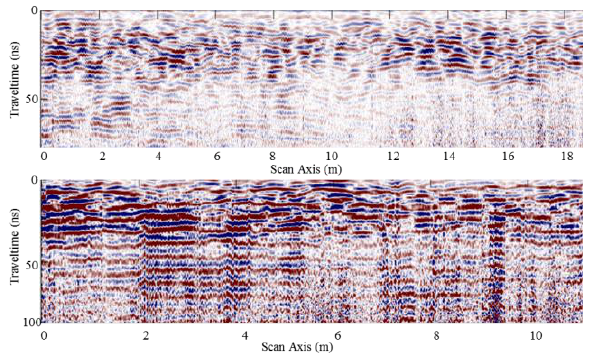
Figure 13. 270 MHz scans of vertical surfaces of the brick plinth of Nyatapola. Note the different display contrasts and horizontal axes.